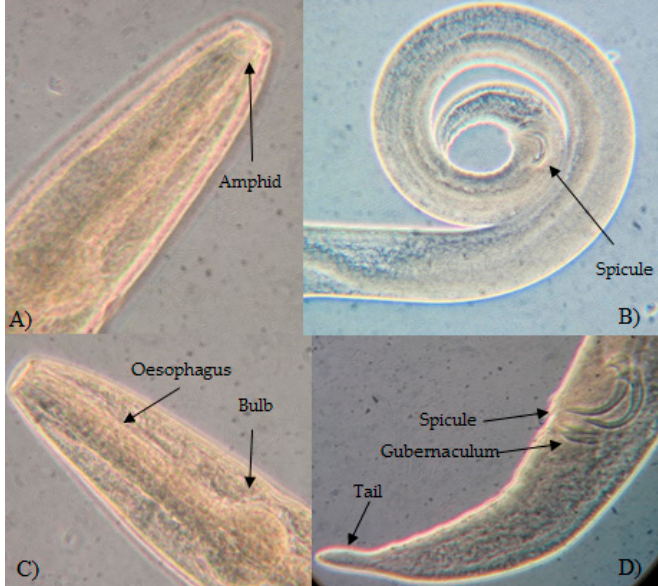
Figure 2. Spirinia sp.2. Adult male. ( A ) Head showing circular amphid. ( B ) Posterior part of the body showing tail and spicule. ( C ) Anterior part of the body showing esophagus and esophageal bulb. ( D ) Posterior region showing spicule, gubernaculum, and tail shape.